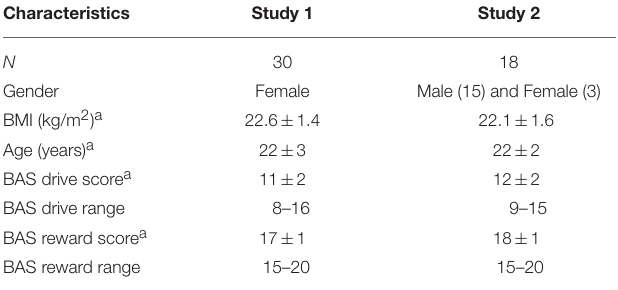
TABLE 1 | Participant